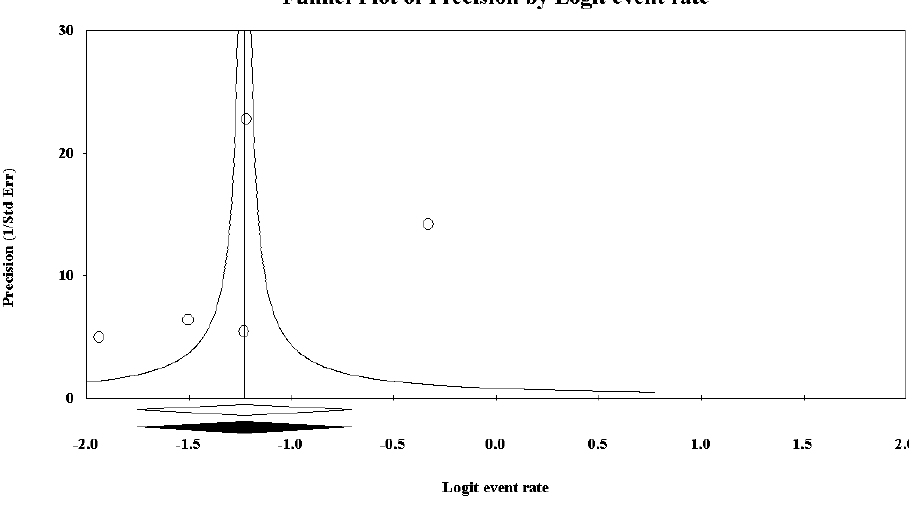
Figure 9. Funnel plot for alcohol consumption rate among truck-drivers based on the AUDIT-CAGE instruments, showing no evidence of publication bias.